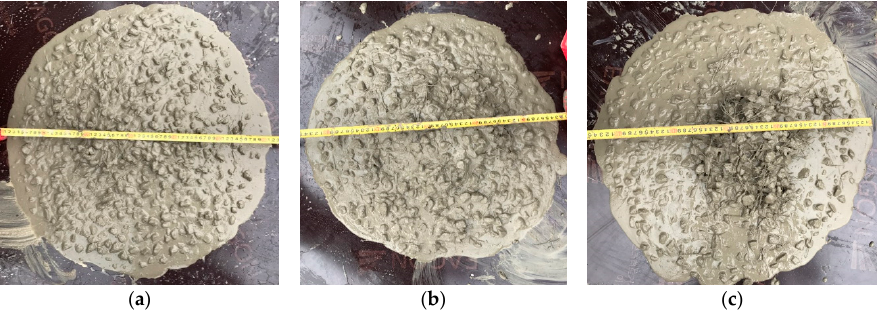
Figure 2. Slump flow test results (3D hooked fiber case): ( a ) v f of 0.37%, ( b ) v f of 0.6%, and ( c ) v f of